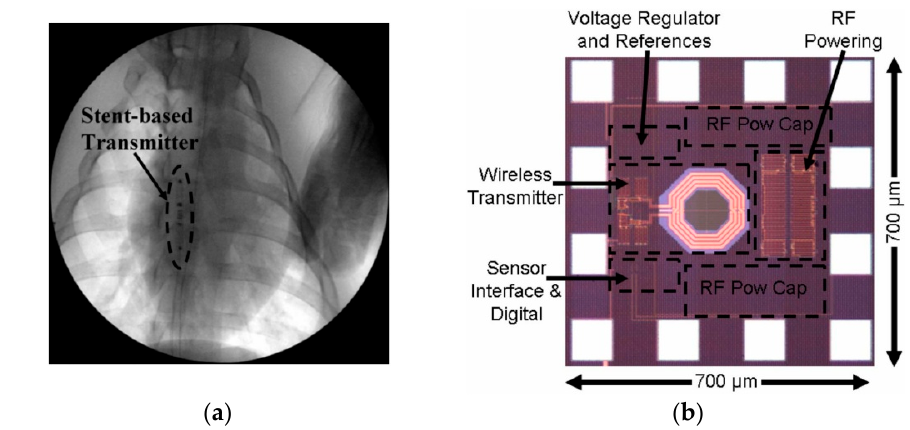
Figure 39. Implantable cardiovascular pressure monitoring system [181]. ( a ) Radiograph of stent implanted in the chest cavity of a live porcine. ( b ) Optical microscope picture of ASIC including WPT antenna. Copyright © 2010, IEEE.